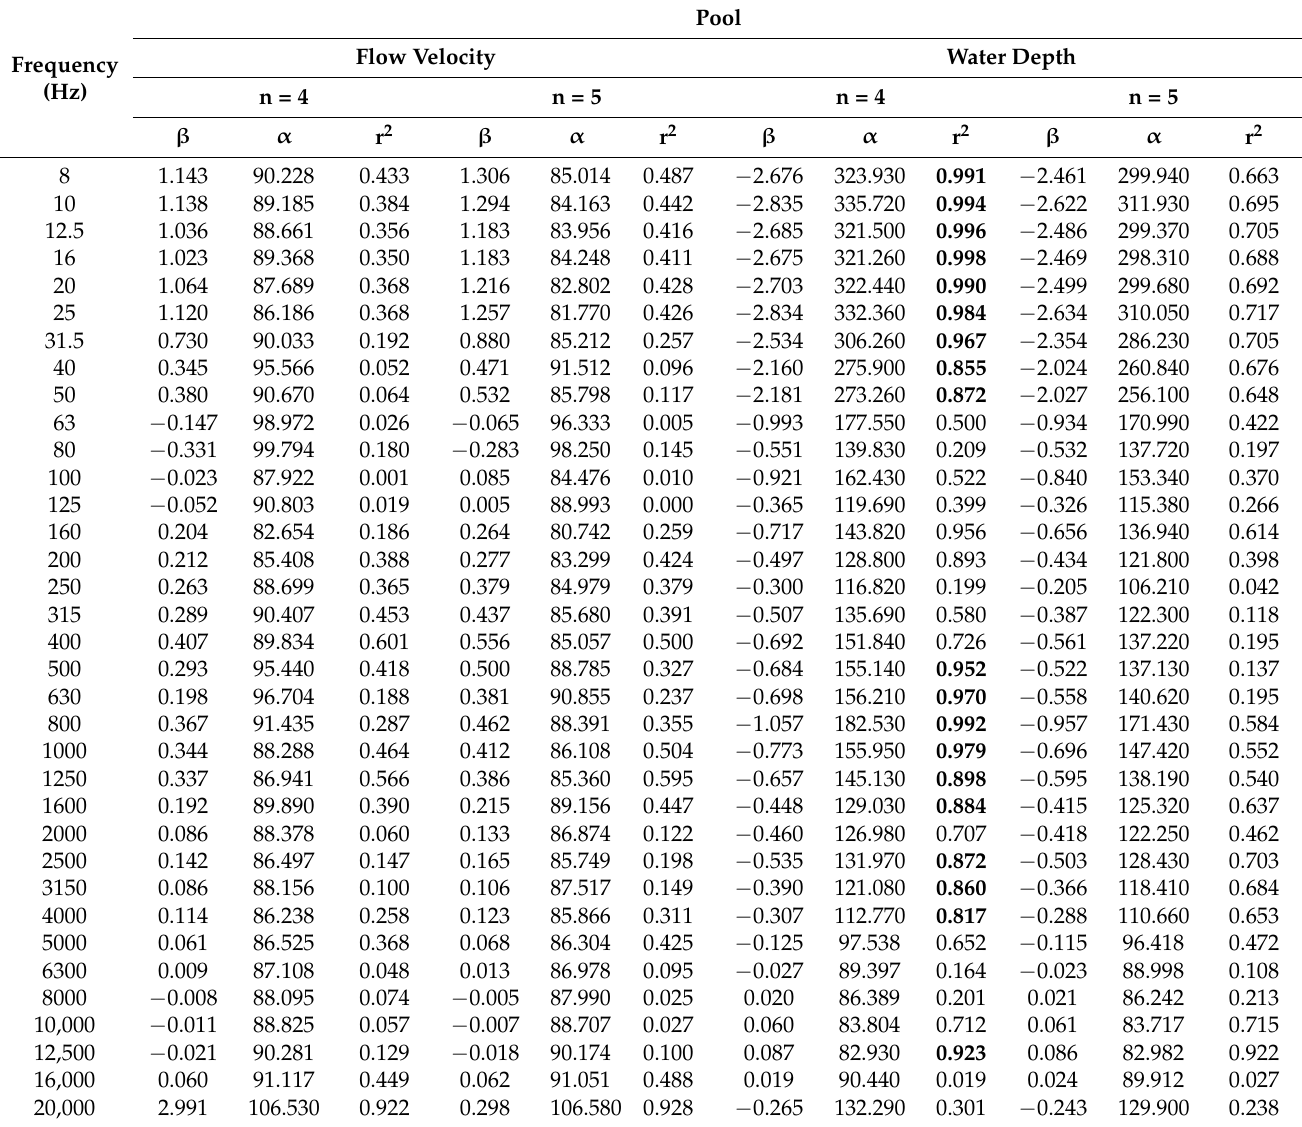
Table 4. The slope β , regression intersect α , and the determination coefficient r 2 of the linear regression for the relationship between underwater SPL(Y) and flow velocity/water depth(X) in a pool. n = 5 is the number of spots, including all pools, and n = 4 is except to H8 from